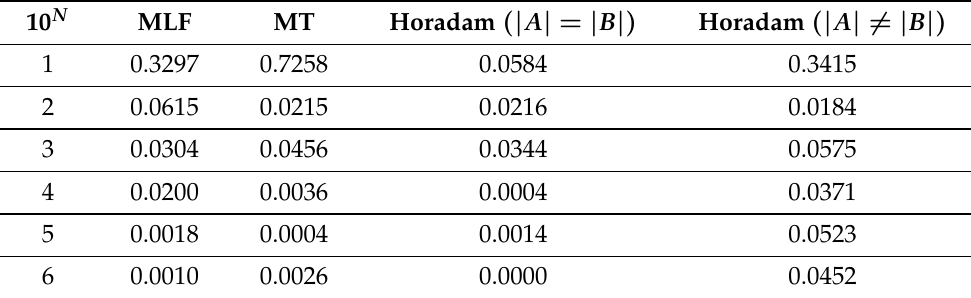
Table 1. Absolute errors in the approximation of π